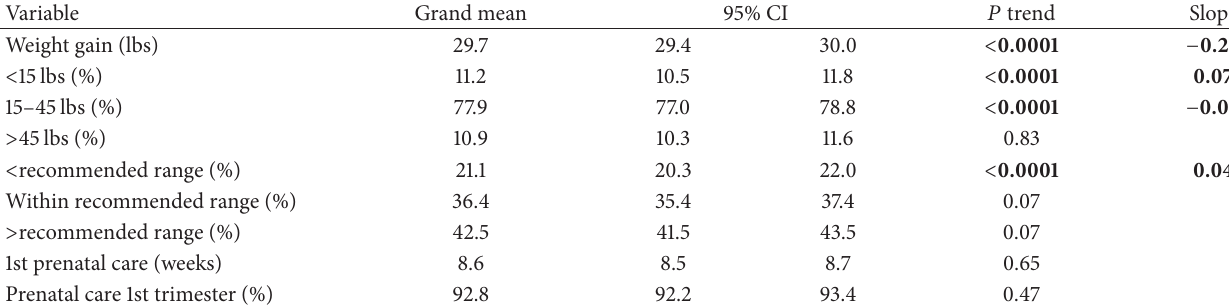
Table 2: Pregnancy weight gain and prenatal care for women giving birth in Maine, 2000–2010.